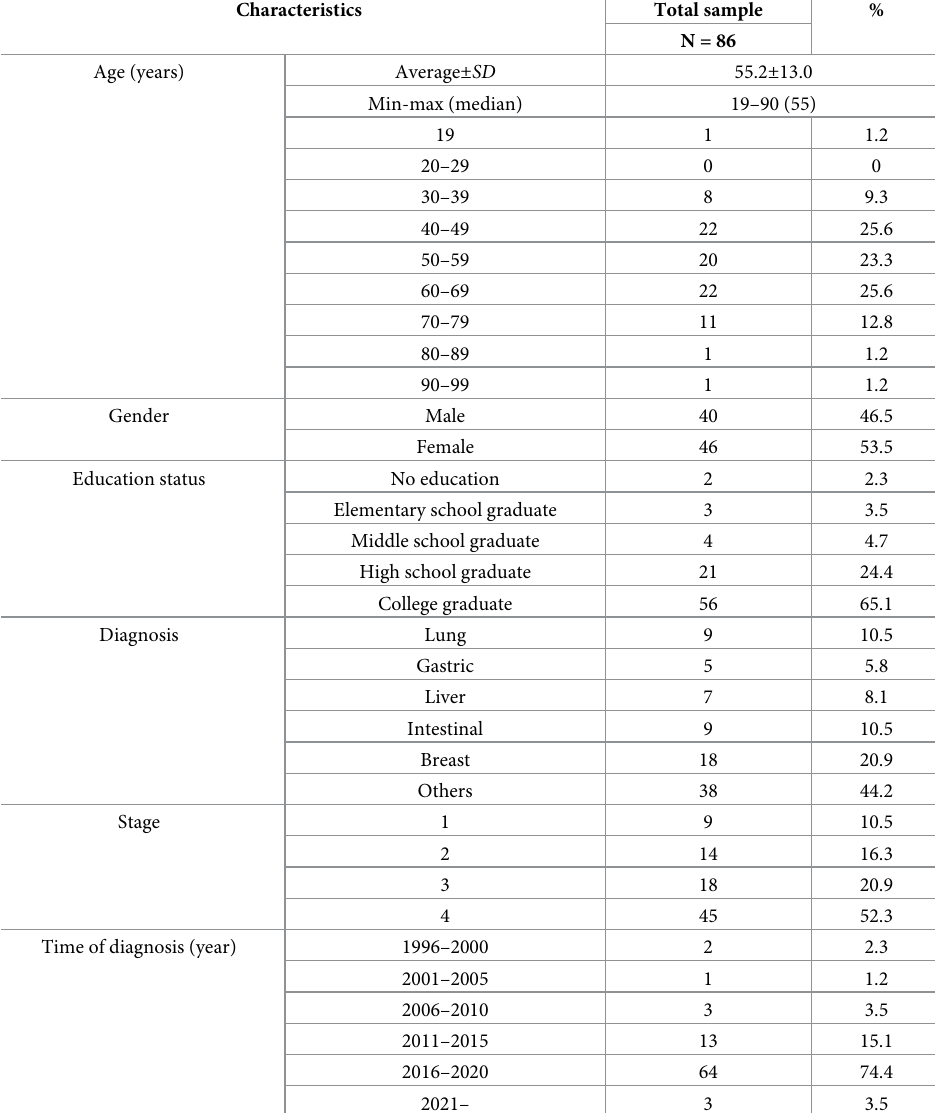
Table 1. Patients’ general